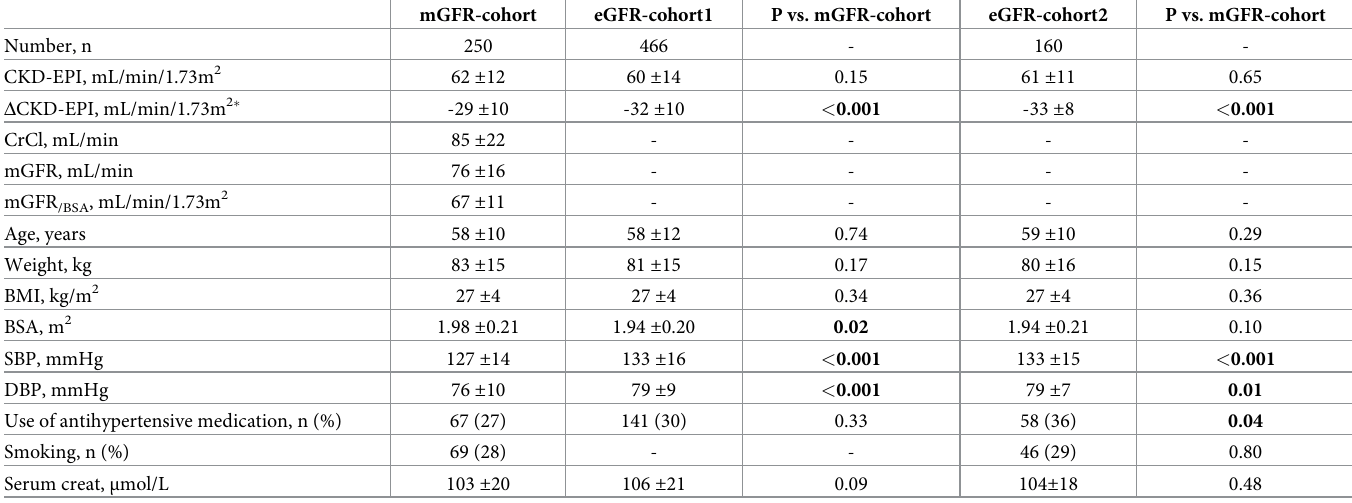
Table 3. Characteristics of the living kidney donors five years after donation.